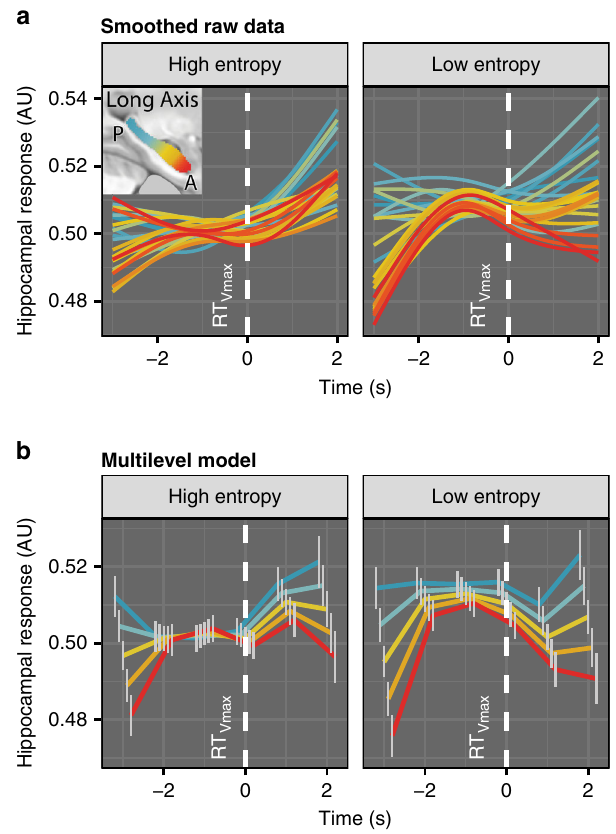
Fig. 3 Online hippocampal responses time-locked to RT Vmax , deconvolved BOLD signal. a Raw data, GAM smoothing with three knots, voxelwise responses shown in 24 long-axis bins. n = 70 participants. RT Vmax is shown with the white dashed line). b Multilevel model, completely general time effect. Centers denote model-estimated mean, vertical gray lines denote standard errors from the multilevel model. n = 70 participants. NB: since voxelwise time series are normalized, only differences in the shape, but not intercept, of response can be